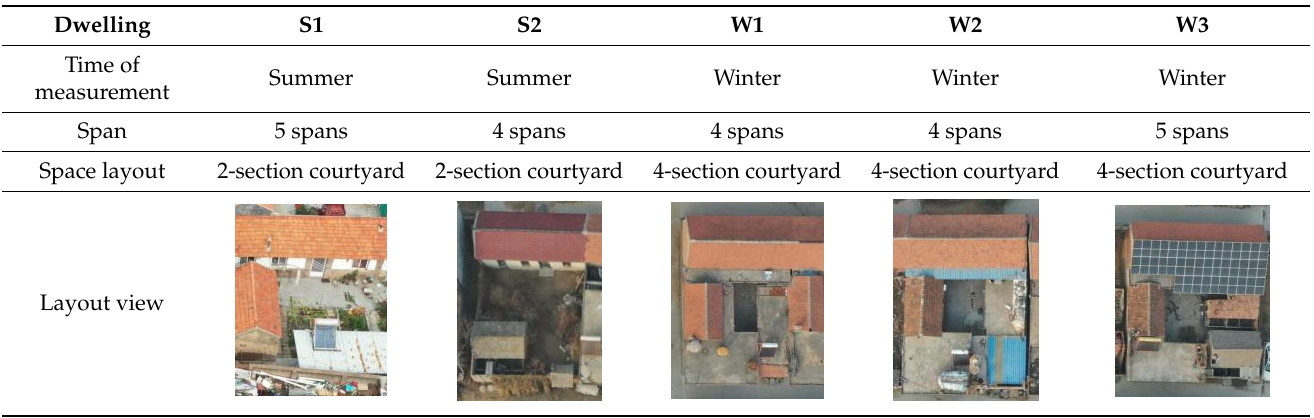
Table 1. Information of the vernacular dwellings.